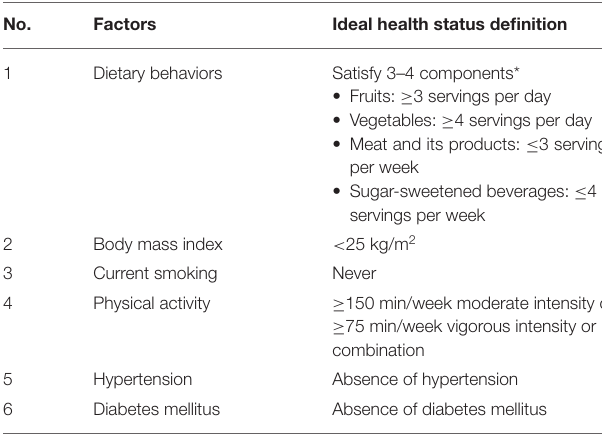
TABLE 1 | Definition of ideal cardiovascular health (iCVH) for